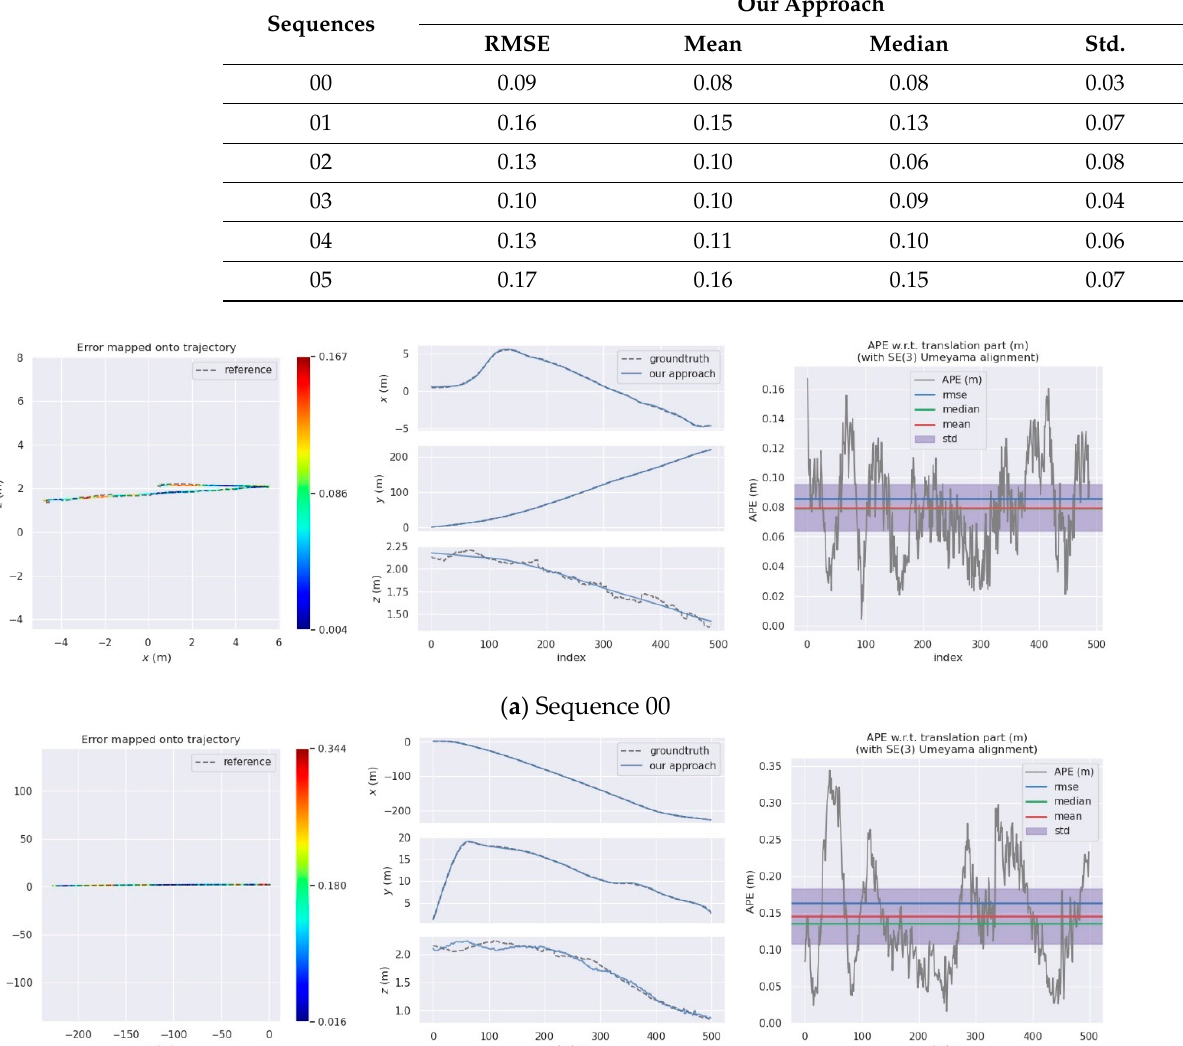
Table 4. Absolute Pose Error (APE) for translation part (Unit: m).